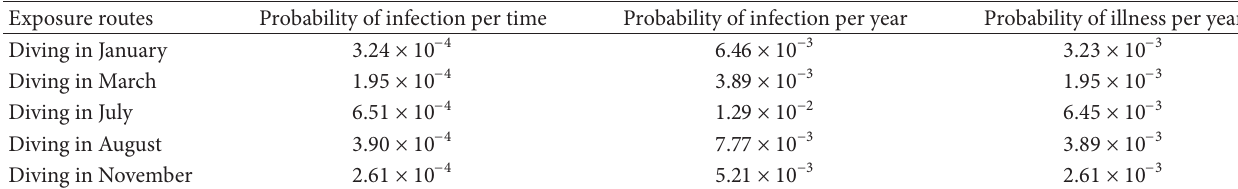
Table 5: Simulated risks by exposure events in Yunlong Lake